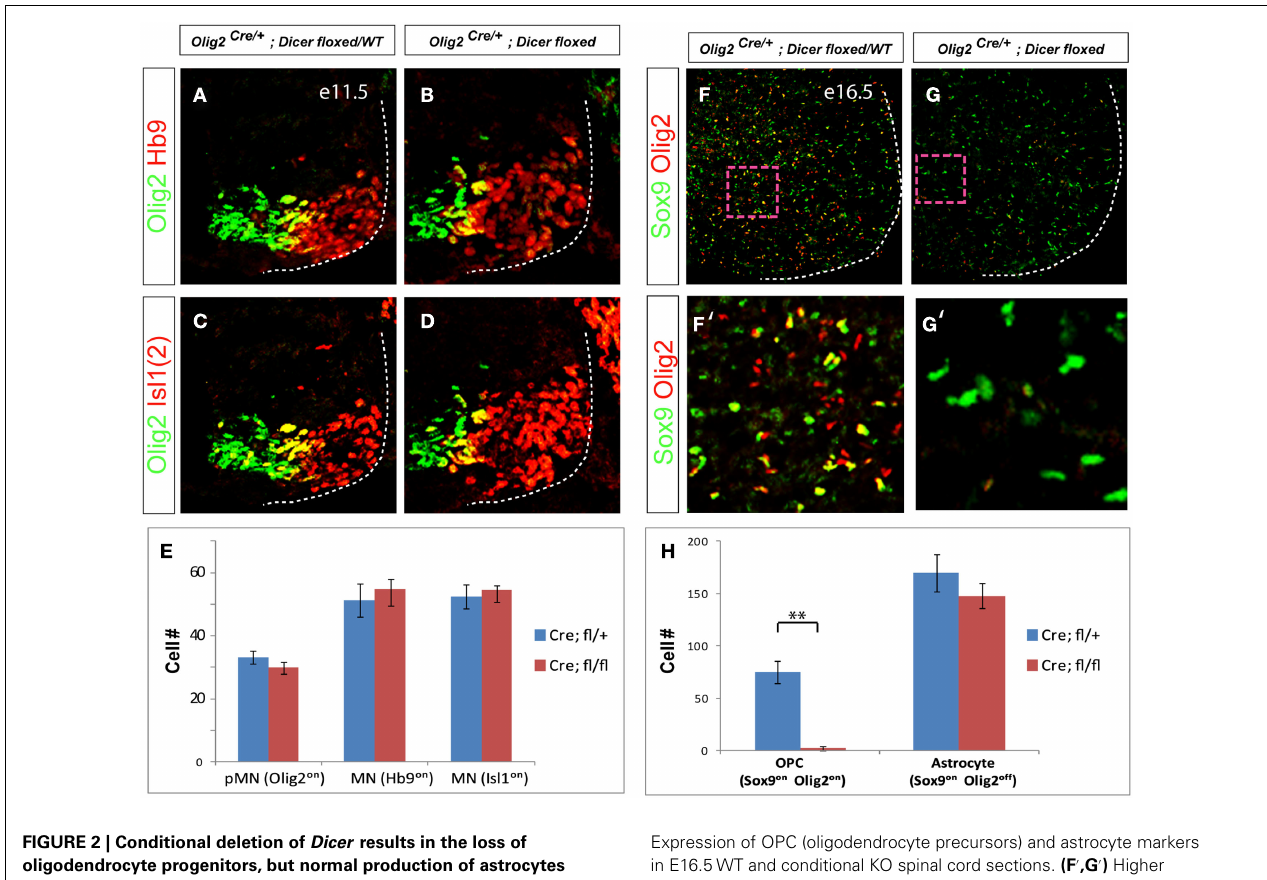
FIGURE 2 | Conditional deletion of Dicer results in the loss of oligodendrocyte progenitors, but normal production of astrocytes and motor neuron progenitors. (A–D) Specification of pMN (Olig2 on ) progenitors and generic motor neurons (Isl1 on or Hb9 on ) are not affected in Olig2 Cre/ + ; Dicer flox/flox spinal cord at E11.5. (E) Quantification of ventral pMN and postmitotic motor neurons (MNs; number of positive cells per 15 μ m brachial spinal cord hemisection) inWT and conditional KO embryos (mean ± SD) reveals a comparable cell number of pMN progenitors and generic motor neurons ( N = 3 embryos at E11.5).